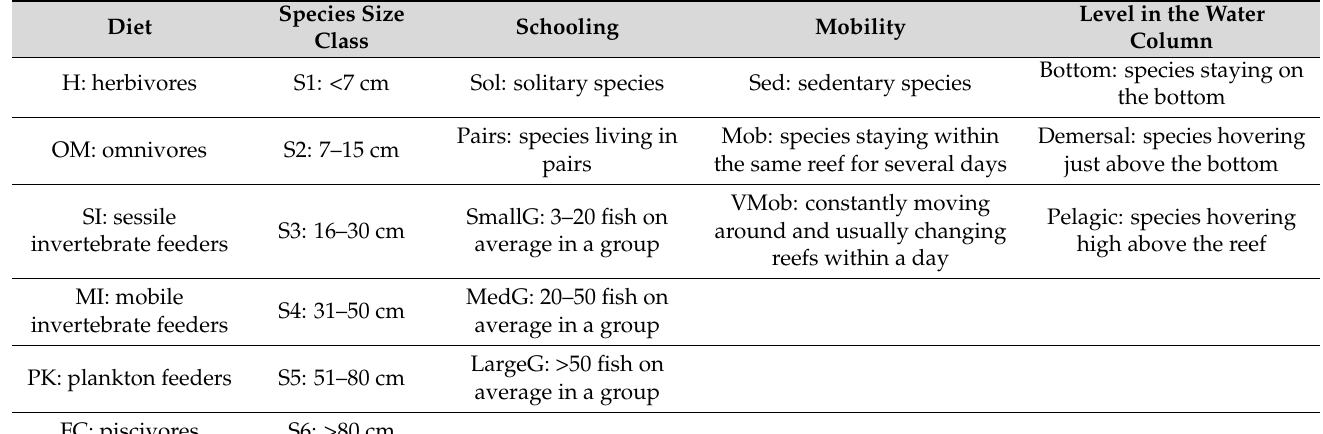
Table 1. Levels considered within each of the five eco-morphological